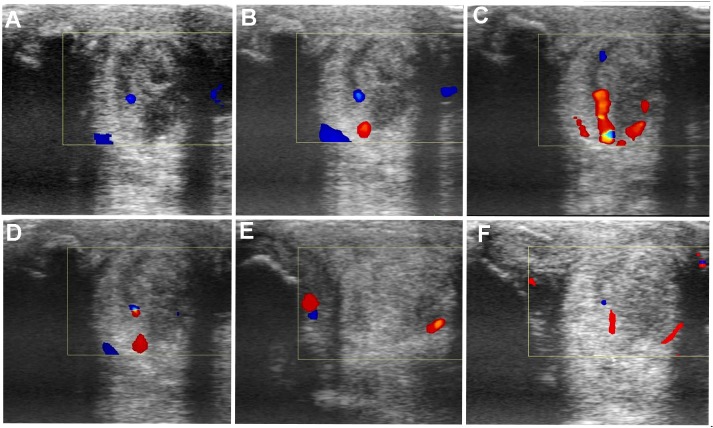
Transverse and longitudinal color Doppler ultrasonography projections prior to plasmid DNA encoding VEGF164 and FGF2 genes (A) and 20 (B), 40 (C), 90 (D), 180 (E), 360 (F) days after administration in horse #3 – SLB desmopathy.